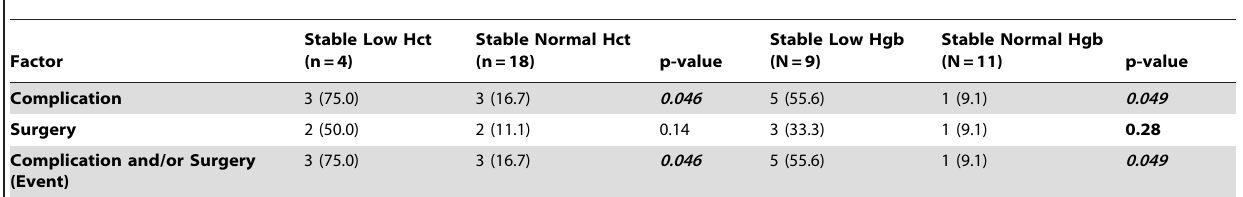
Table 4. Hemoglobin & Hematocrit with Multiple Samples During Follow-up.